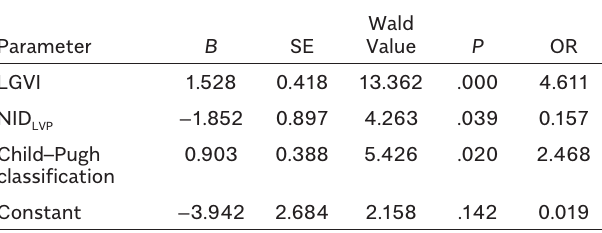
Table 5. Logistic Analysis after Adding Spectral CT Parameters